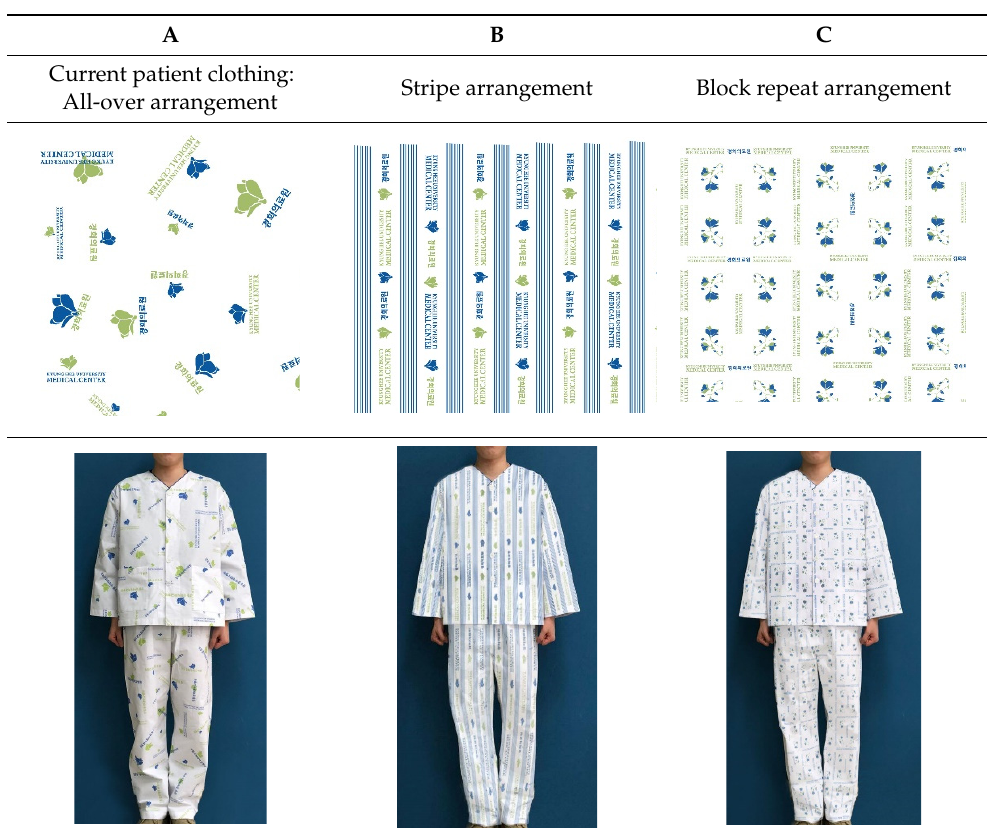
Table 3. Comfort healing characteristics: patient clothing design stimulus.